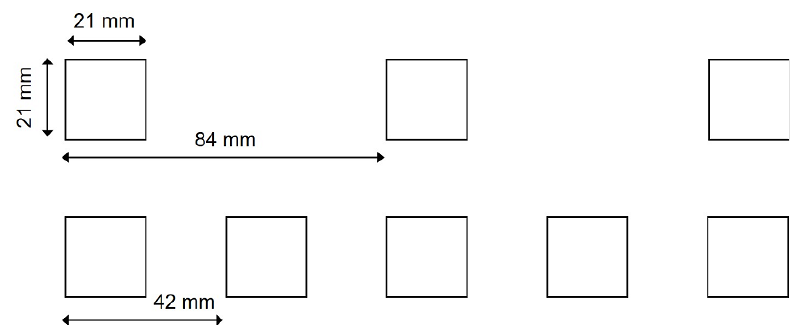
Figure 1. Cross-sections of R-1 ( Upper ) and R-2 ( Lower ).